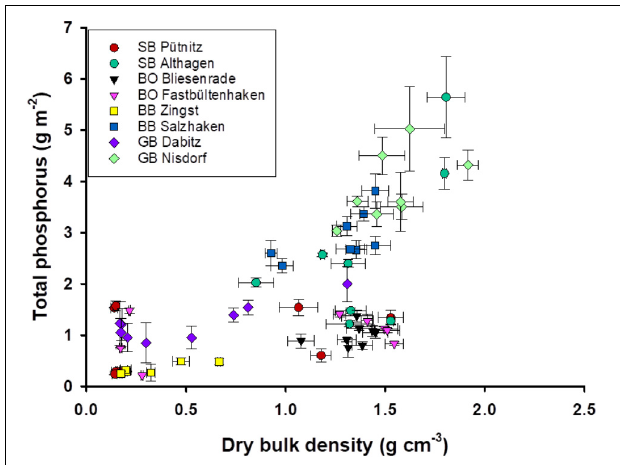
FIGURE 4 | Total phosphorus stock (g P m − 2 ) and dry bulk density (g dry mass cm − 3 ). Error bars are standard deviation of three replicate measurements for DBD and four for